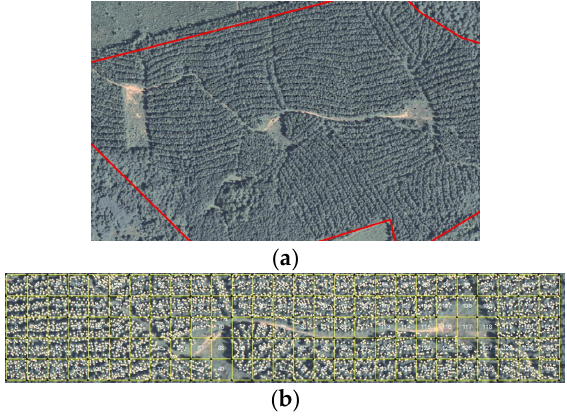
Figure 2. Aerial images for the Southeastern United States study site. Panel ( a ) displays a recently thinned, 17 ‐ year old plantation, containing planting rows with curvature and numerous switches in planting direction; Panel ( b ) is the 13.1 ha rectangle from the center of the stand and contains 135 quadrants with dimensions of 31.15 × 31.15 m. Individual trees were mapped and depicted with white